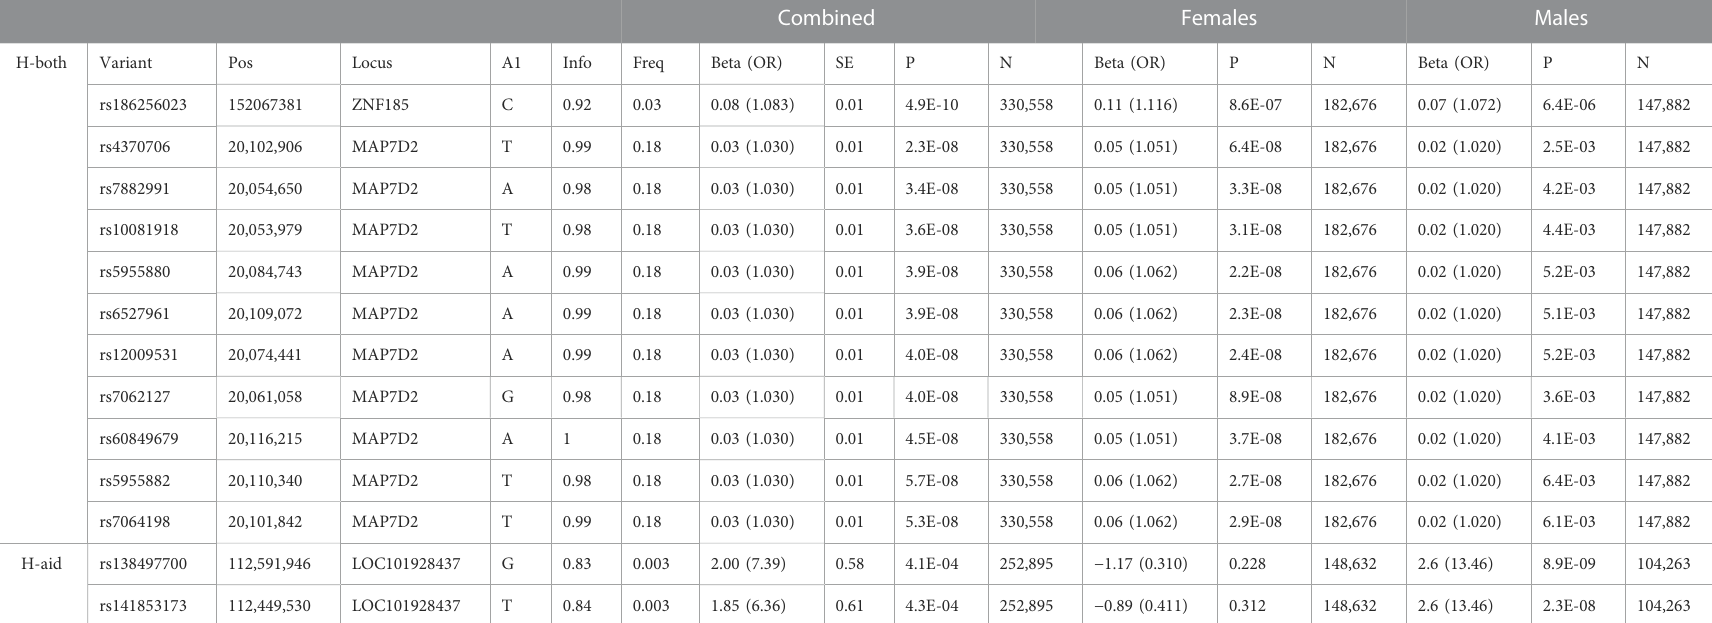
TABLE 1 Variants associated with age related hearing loss.